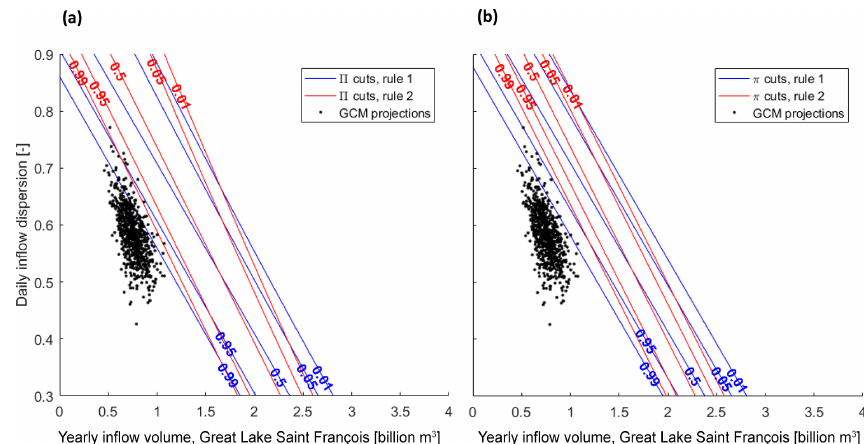
Figure 9. Compared logistic regressions, Rules 1 and 2, and GCM projections for (a) fuzzy outcomes and (b) binary outcomes.